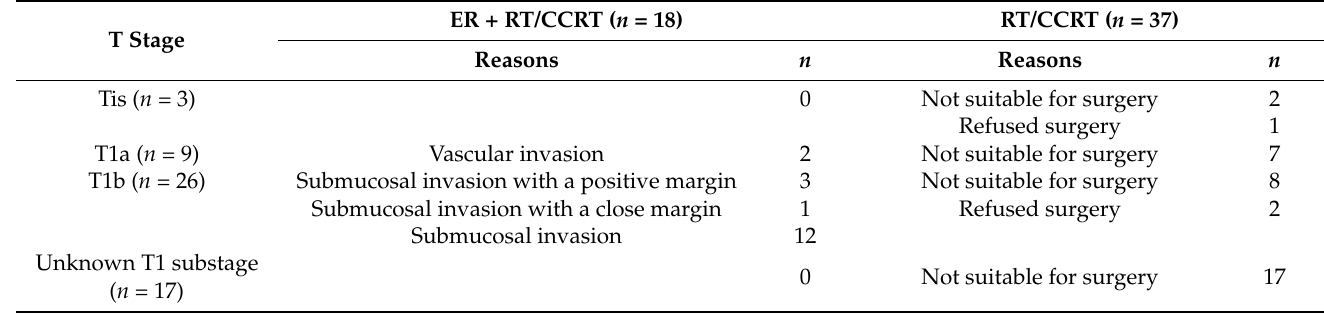
Table 2. The reasons for receiving different treatment